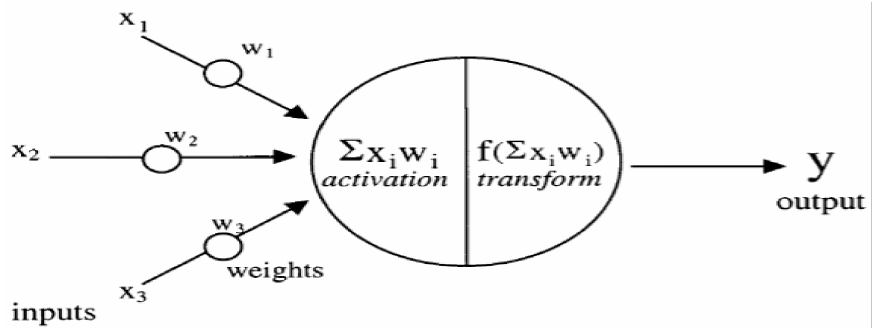
Figure 1. Basic components for ANN neuron model. Copyright © 2021 Elsevier